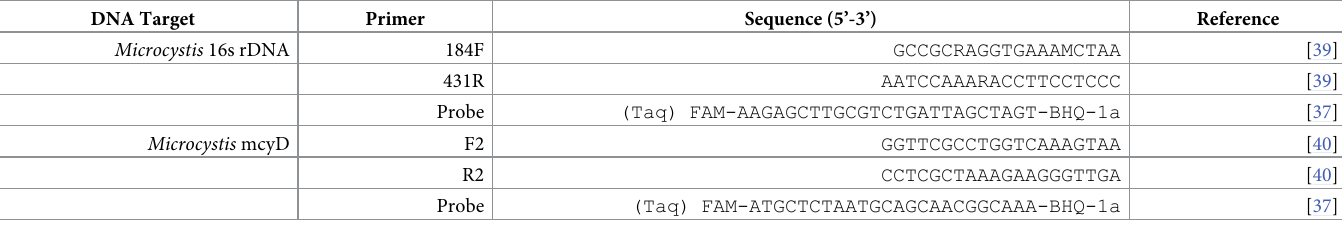
Table 2. A list of primers (Integrated DNA Technologies, IA, USA) and probes (Applied Biosystems, Foster City, CA, USA) used in the qPCR analysis). DNA